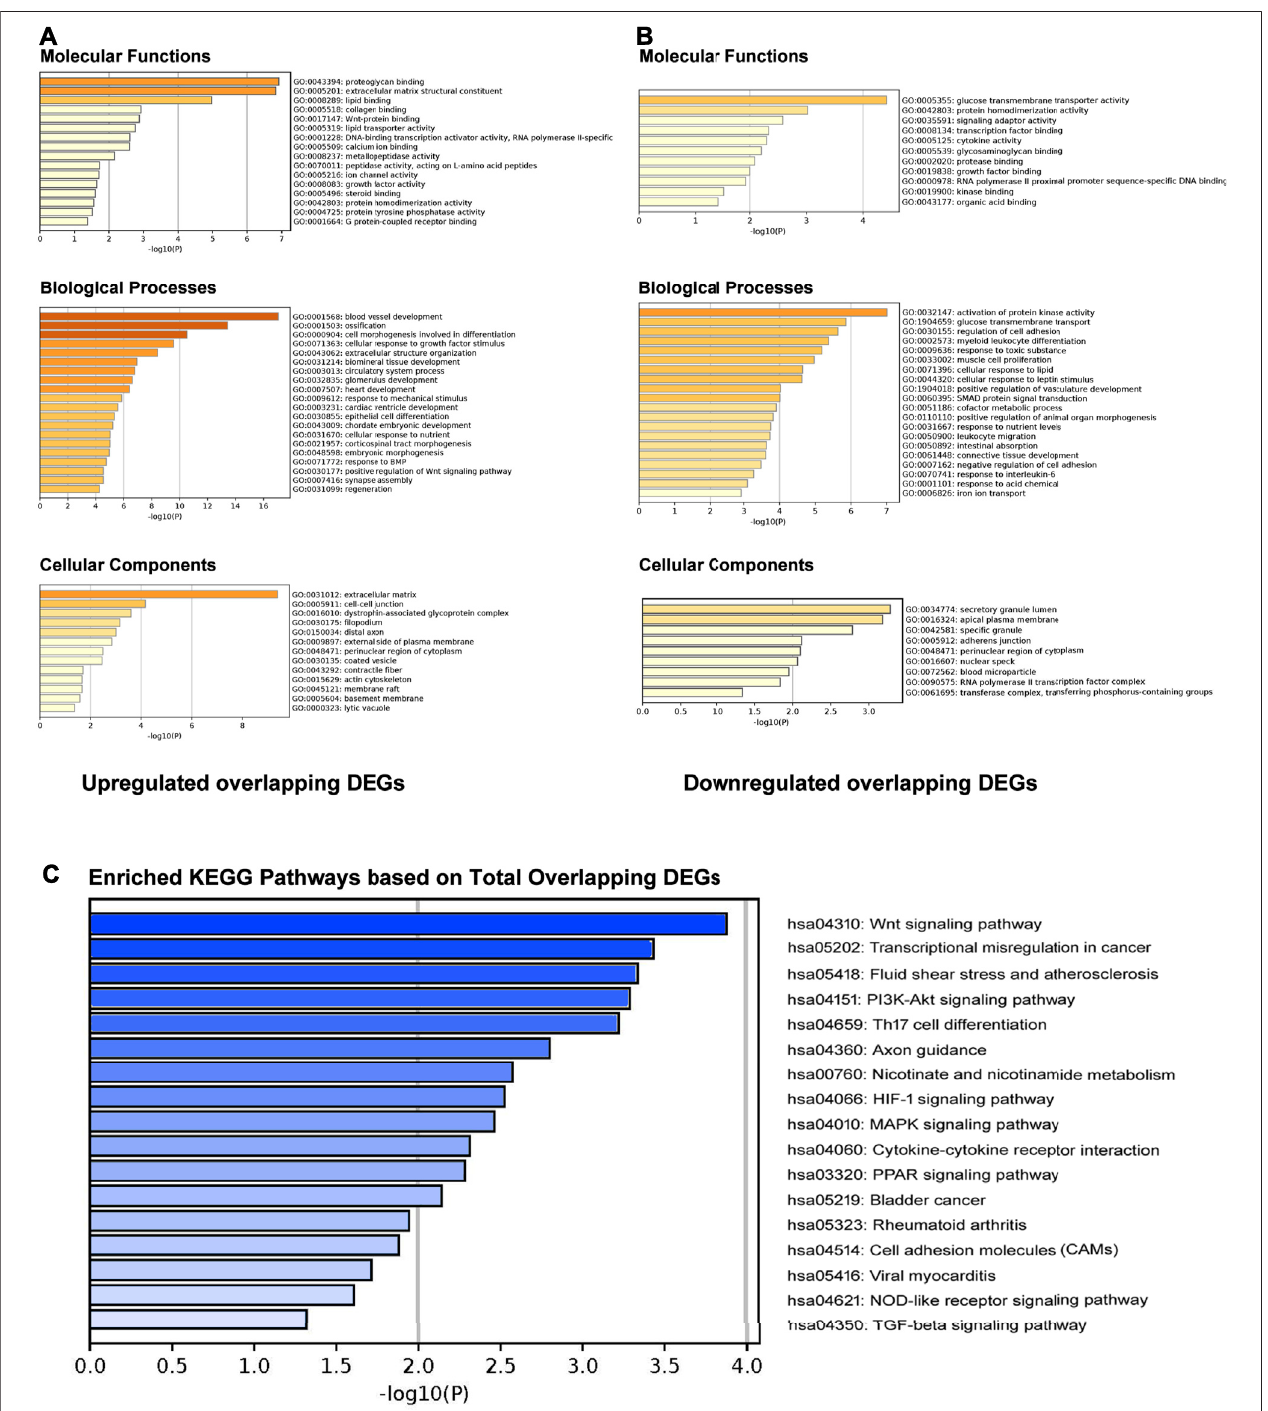
FIGURE 2 | GO enrichment and KEGG pathway analyses. (A) GO molecular functions, biological processes, and cellular components enrichment analysis on upregulated overlapping DEGs. (B) GO molecular functions, biological processes, and cellular components enrichment analysis on downregulated overlapping DEGs. (C) Enriched KEGG pathways based on total overlapping